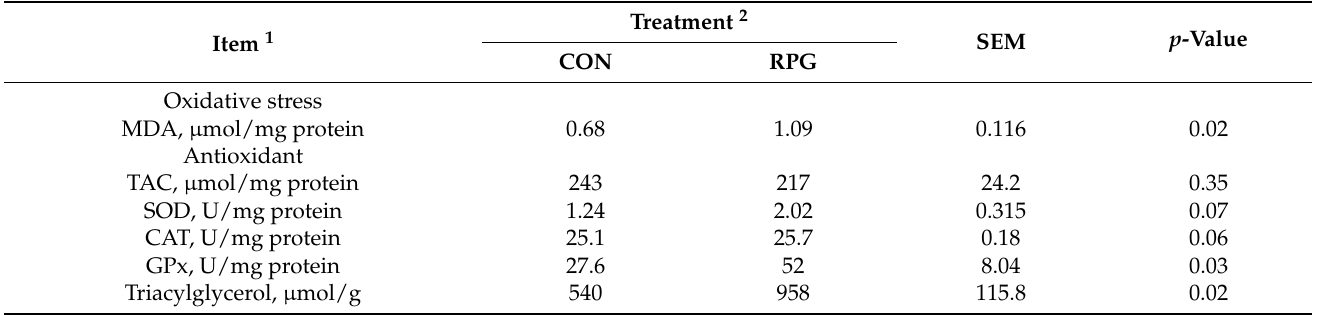
Table 1. Effects of rumen-protected glucose (RPG) on the variables of oxidative stress, antioxidant capacity, and triglyceride content in the liver of early postpartum cows ( n pairs =